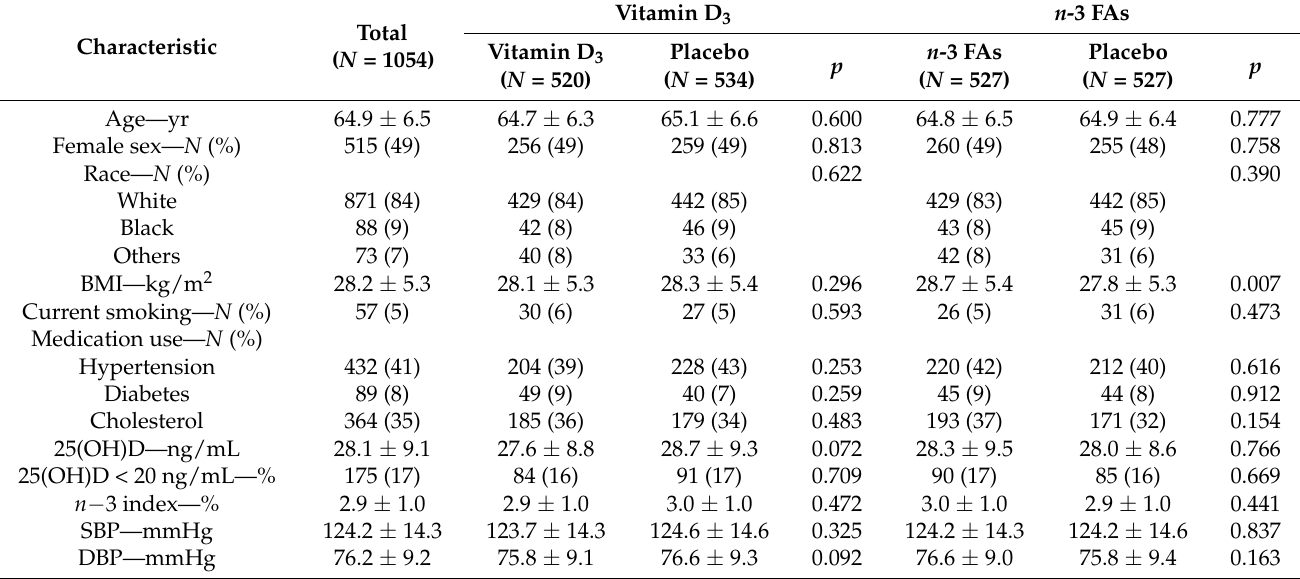
Table 1. Characteristics of the CCI participants at baseline according to vitamin D 3 and marine n -3 FAs